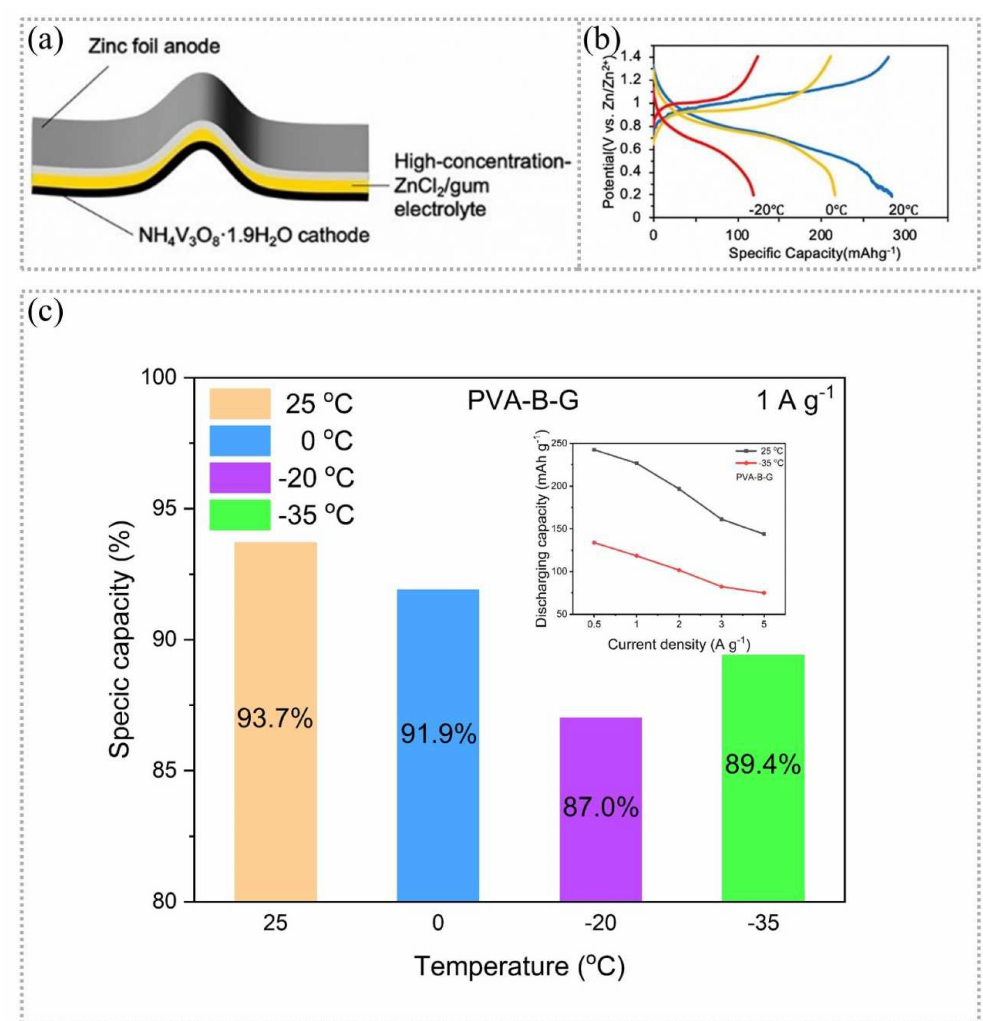
Figure 8. ( a ) Schematic illustration showing the cross-section view of a HCSE battery with zinc foil anode, high-concentration ZnCl 2 /xanthan gum electrolyte, and the NH 4 V 3 O 8 · 1.9 H 2 O cathode sandwiched together. ( b ) Galvanostatic discharge/charge curves of the HCSE battery cycled under 0.2 A g − 1 at 20, 0, and − 20 ◦ C, respectively. Adapted with permission from Ref. [57]. Copyright 2020 ACS Applied Energy Materials ( c ) After 2000 cycling performances of the PVA-B-G battery at 1 A g − 1 at different temperatures, compared with the 1st cycle at 25, 0, − 20, and − 35 ◦ C, respectively. The inset of the figure presents the rate performances of PVA-B-G at 20 and − 35 ◦ C